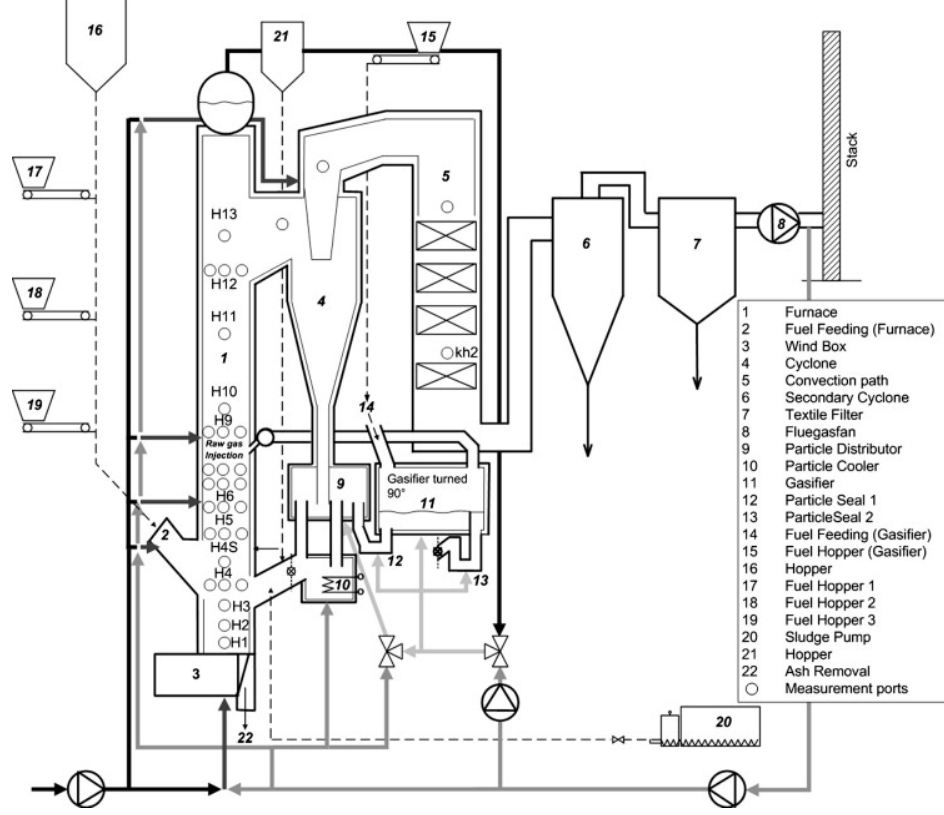
Figure 2. Schematic description of Chalmers research boiler/gasifier reactor system.